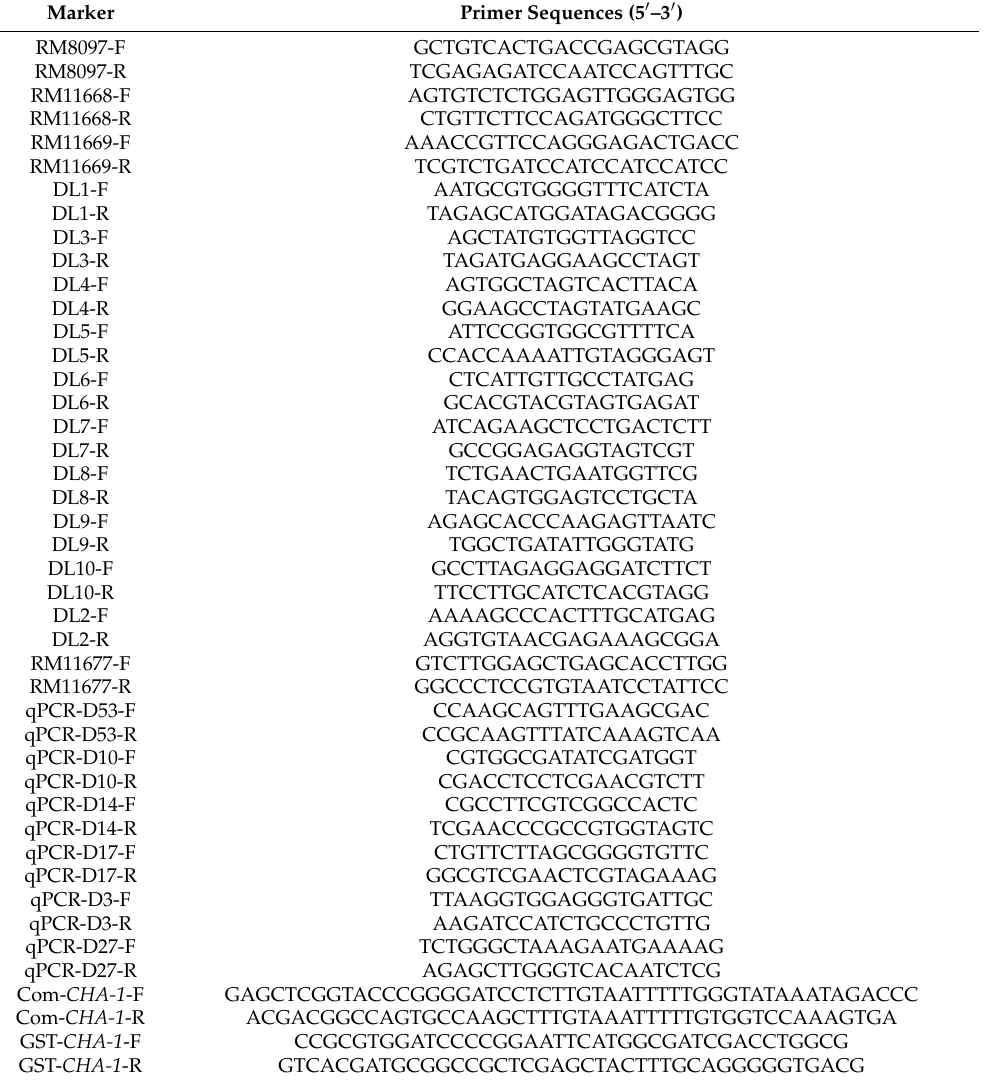
Table 3. Primers used for the fine mapping of CHA-1 and quantitative real-time